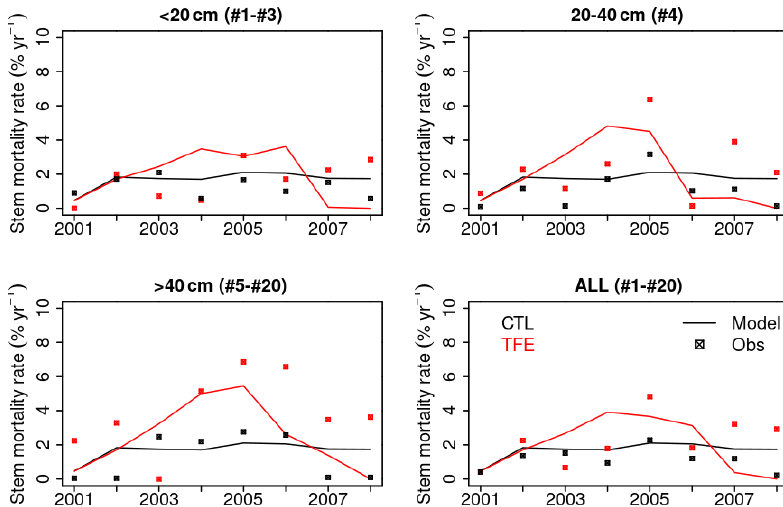
Figure 11. Annual stem mortality rates during the study period (2001–2008). All 20 cohorts have been aggregated to three classes according to DBH ( < 20, 20–40, > 40cm). The value in brackets in the title of each panel corresponds to the cohort numbers falling in the